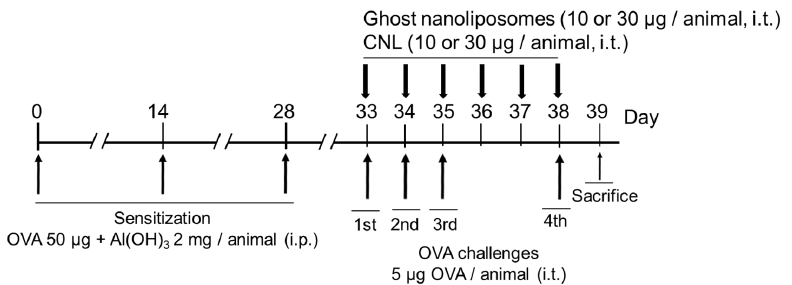
Figure 1. Animal experimental schedule. Mice were sensitized with OVA absorbed to Al(OH) 3 on days 0, 14, and 28. Mice were intratracheally challenged with OVA-free PBS or OVA on days 33, 34, 35, and 38. At the indicated time points, Ghost or CNL (10 or 30 μg /mouse) were intratracheally administered prior to OVA challenges. Twenty-four hours later, mice were sacrificed.